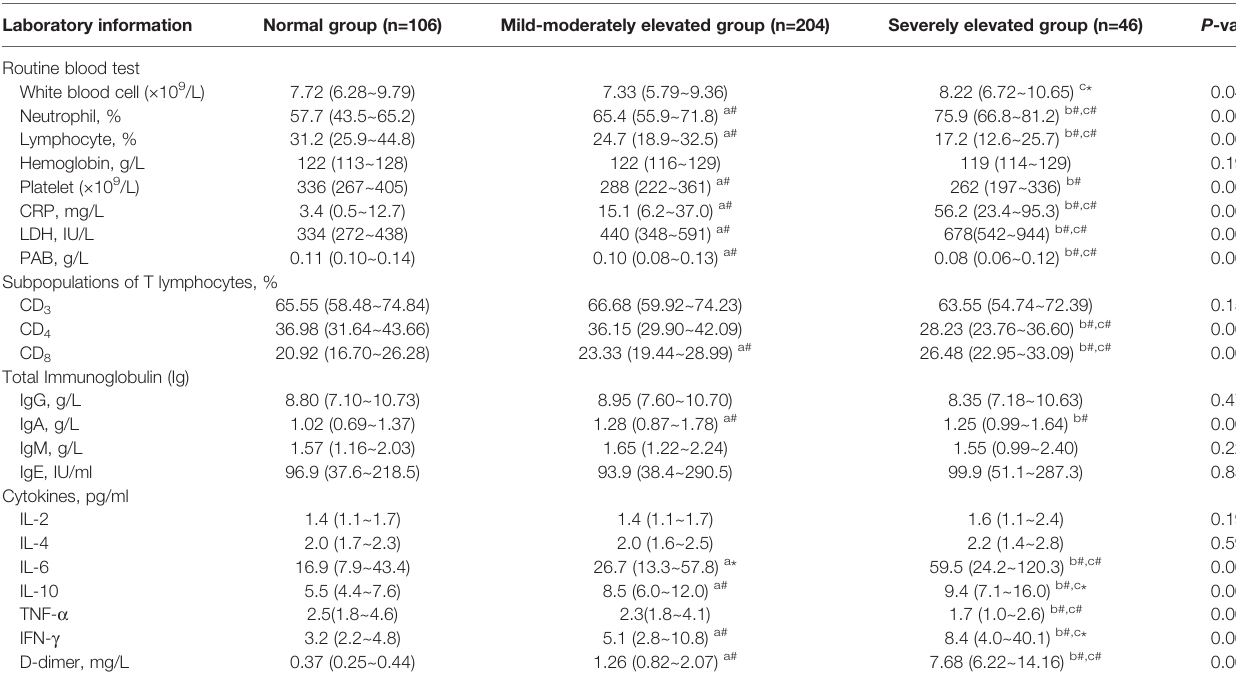
TABLE 2 | Laboratory fi ndings of patients with MPP on admission. Laboratory